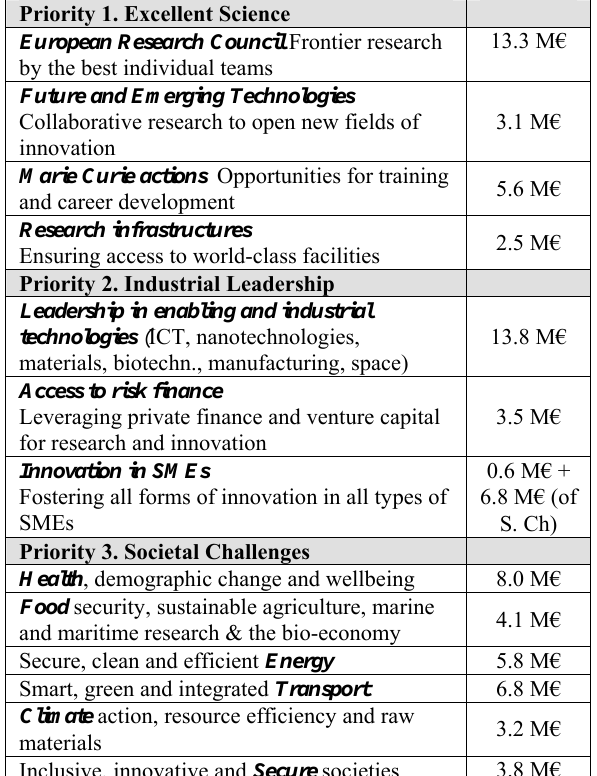
Table 1. H2020 funding (period 2014-2020) Priority 1. Excellent Science